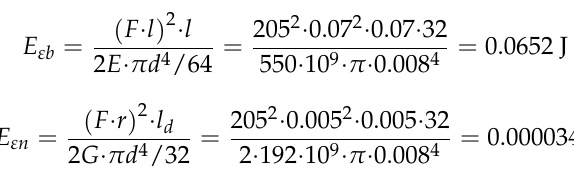
Figure 6. Cycles of the combined displacement of the cutter in the X and Y directions. (2)